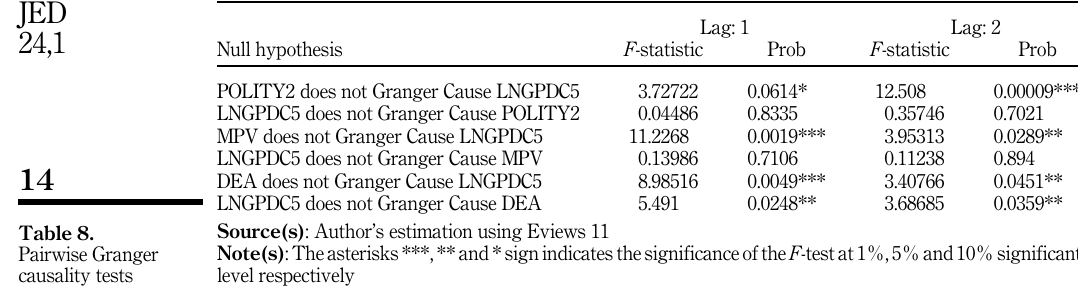
Table 8. Pairwise Granger causality